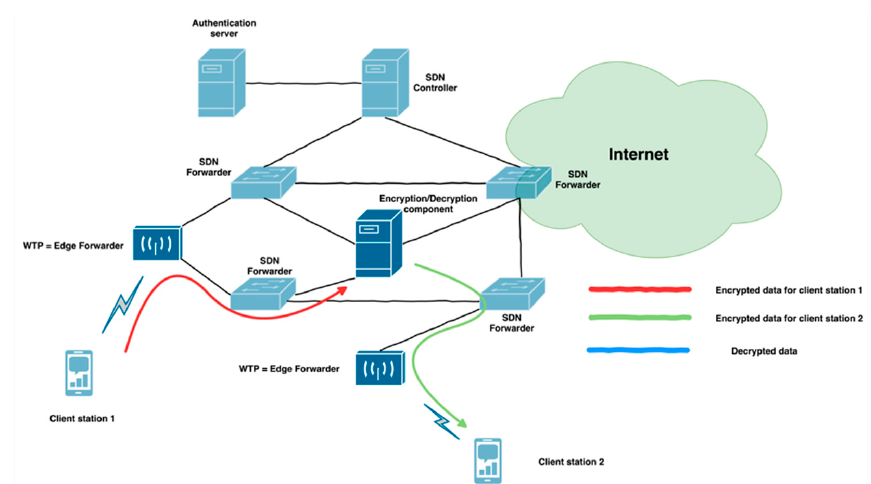
Figure 5. Data flow between two client stations in the same 802.11 network.